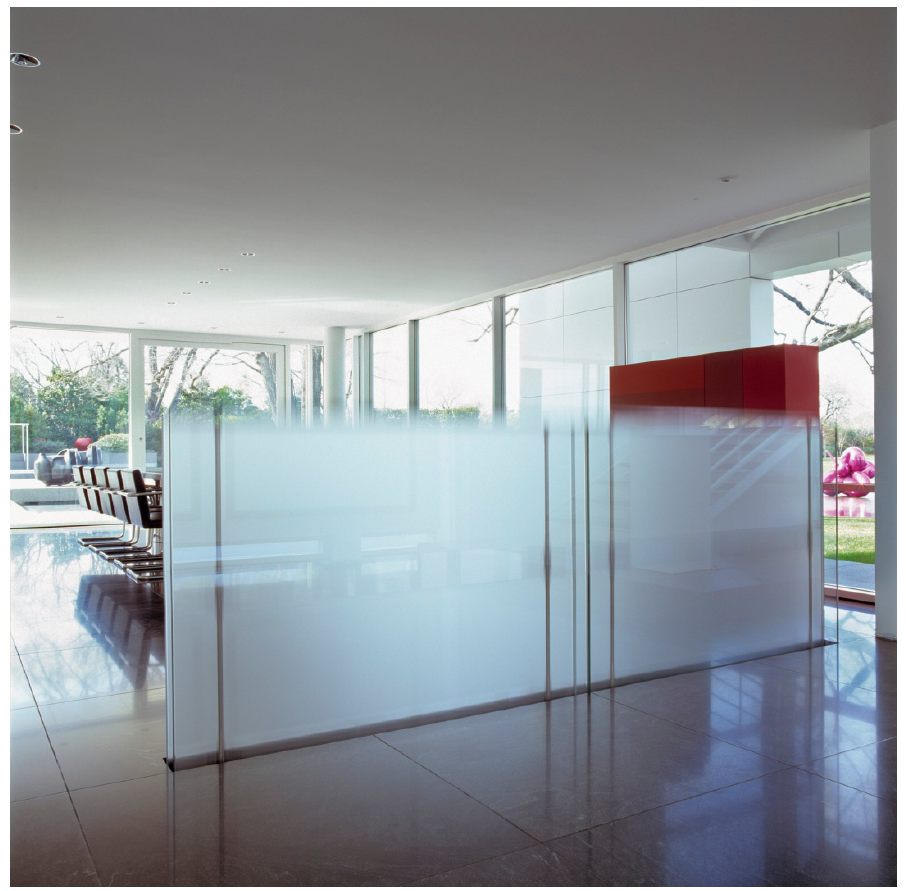
Figure 2: view from the gallery of the “Retracting Screen” as it descends into the floor. The concept for the screen grew from the variety of light conditions in the spaces surrounding the screen. The bright lighting on the art objects in the gallery [figure 3a], the subtle light of a private environment [figure 3b], and the daylight playing in different ways on either side of the screen led to the idea of a mutable and dynamically responsive